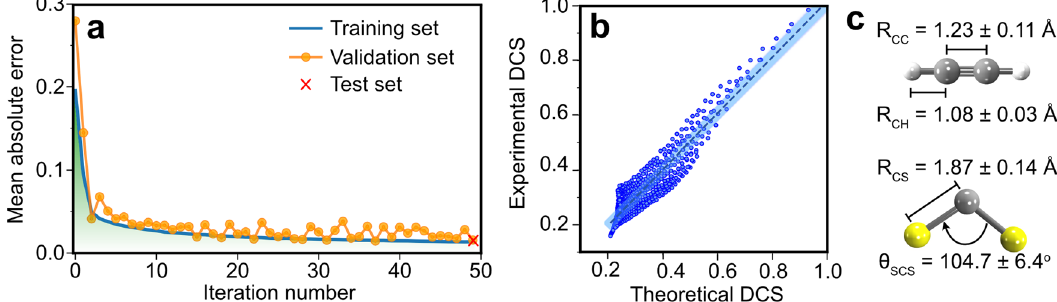
Fig. 3 Evaluating the machine learning results during and after the training process. a Mean absolute error (MAE) obtained for each iteration number that the neural network convolutes the training and validation sets of our simulated data. The MAE obtained with the test data is indicated by the red cross. b Correlation between normalized experimental and theoretical two-dimensional differential cross-section (2D-DCS), reshaped into a 1D array. A linear fi t (blue dashed line) and the 90% con fi dence interval (blue shaded area) using the bootstrapping method are applied to the correlated scatters. A Pearson correlation coef fi cient of 0.94 is obtained, indicating a strong correlation between the two data. c Predicted structural parameters obtained by machine